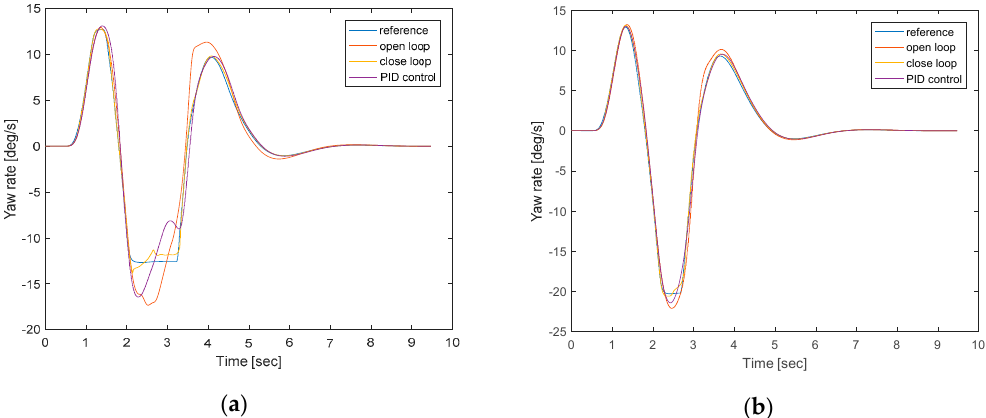
Figure 7. Comparison of yaw rate at 80 km/h with a coefficient of adhesion of 0.5 and 0.8. ( a , b ) reflect the nominal yaw rate, and yaw rate of three control methods at a speed of 80 km/h on a pavement with a pavement adhesion coefficient of 0.5 and 0.8.